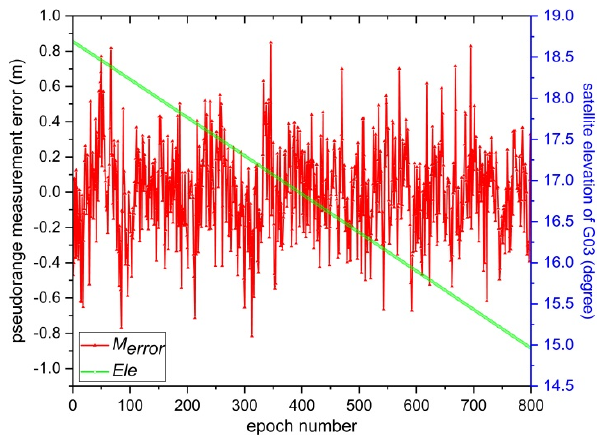
Figure 4. GPS station TB06 under high-voltage transmission line environment (the latitude and longitude of station TB06 are 34 ° 08 ′ 01 ″ and 107 ° 54 ′ 38 ″ , respectively).